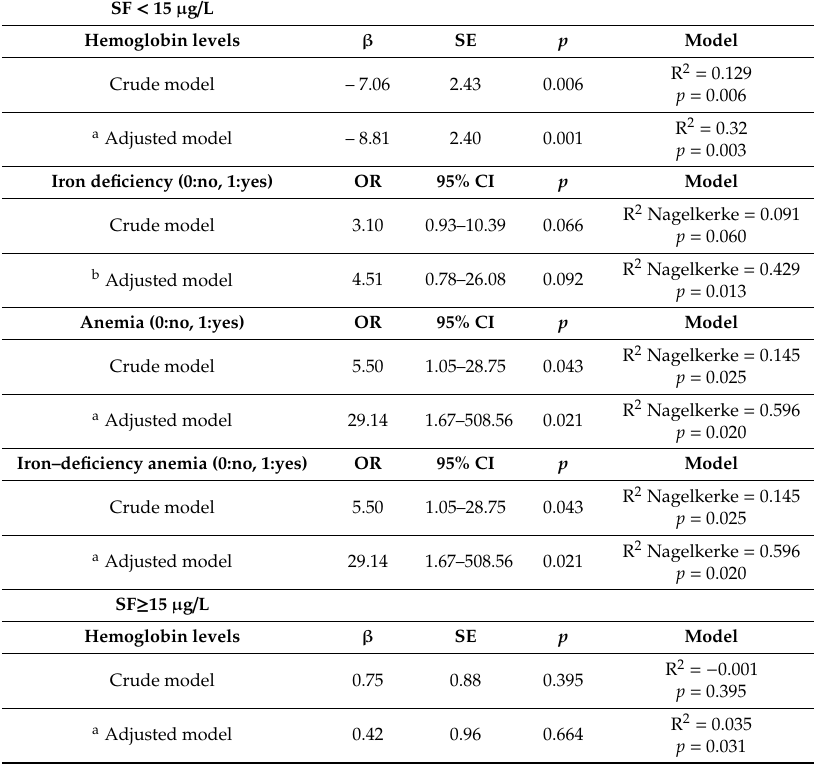
Table 4. The e ff ect of the intervention with iron supplementation in Stratum 1 (0:80 mg / d, 1:40 mg / d) throughout pregnancy on maternal iron status on the third trimester, according to their initial iron